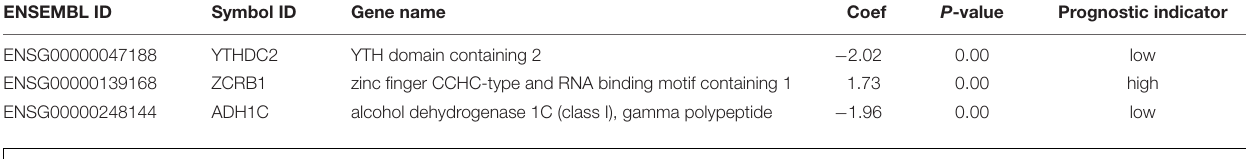
TABLE 2 | Prognosis of the three genes in the signature.